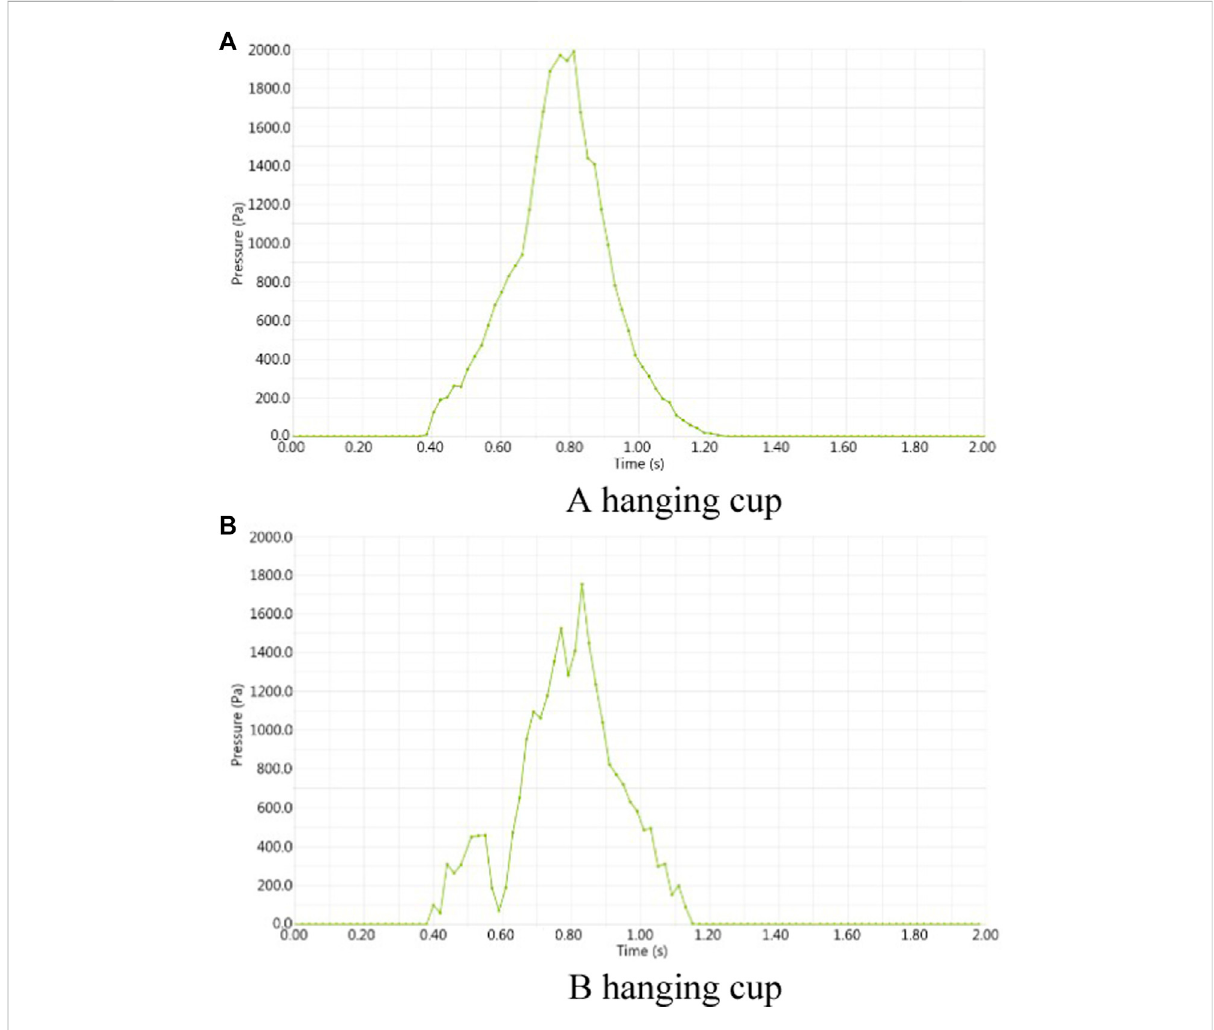
FIGURE 11 Stress diagram of a hanging cup under the condition of no back fl ow of soil.